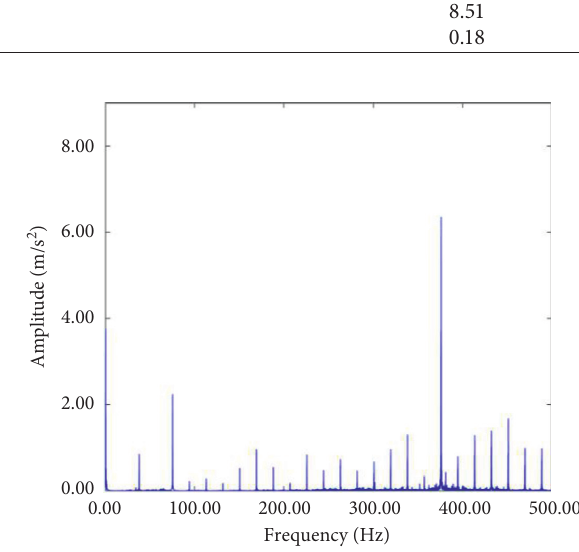
Figure 8: Experimental frequency-domain dynamic response characteristic curves of measuring point 1 in the vertical direction.